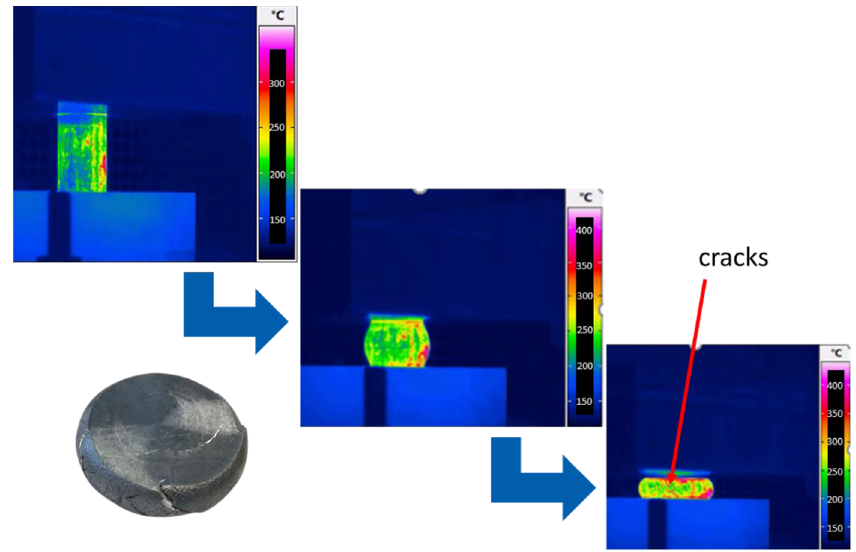
Figure 6. Upsetting process of AlSi1MgMn with IR camera, start temperature: 200 °C.